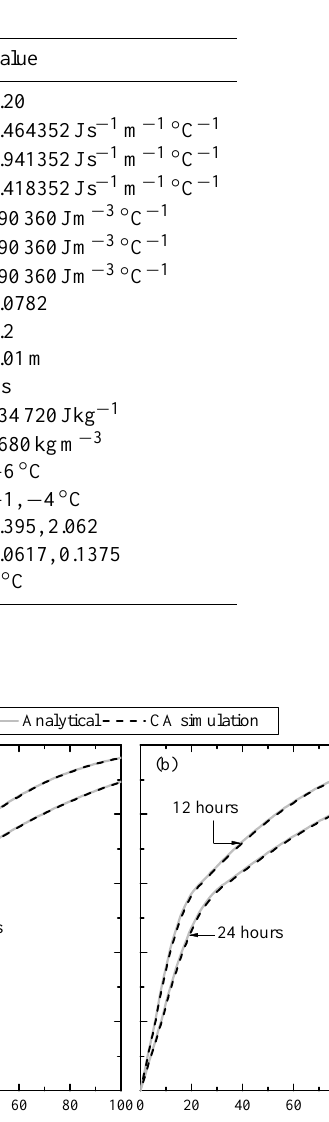
Table 3. Simulation parameters for predicting the subsurface temperature profile with phase change in a three-zone semi-infinite porous medium. The analytical solution to this one-dimensional problem with sensible and latent heat zones is given by Eqs. (18)–(25) as per Lundardini (1985).